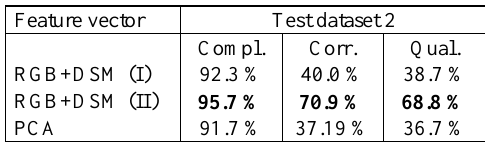
Table 3. Quantitative evaluation results for test dataset